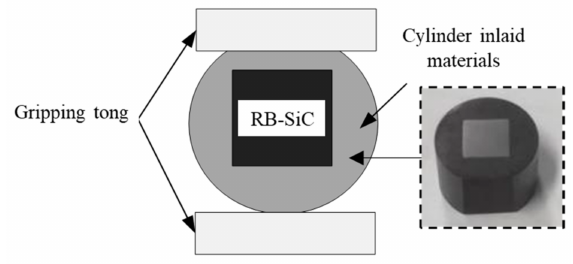
Figure 1. Inlaid treatment of the RB-SiC ceramic sample.